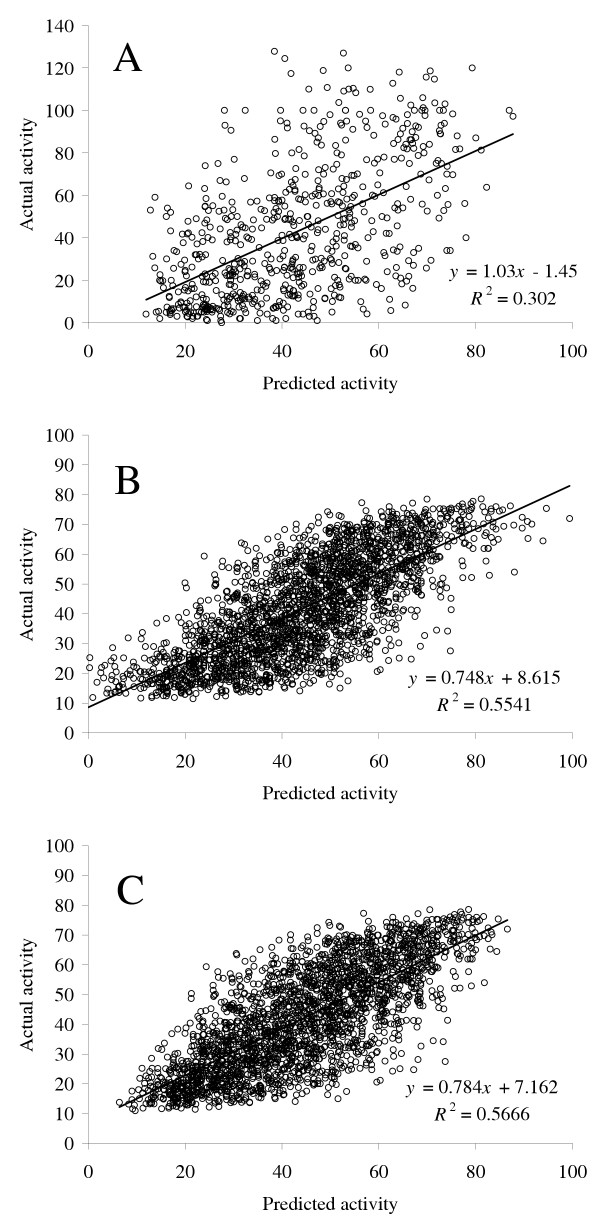
Plot of neural network predictions versus the actual siRNA activity for 653 siRNAs with a broad concentration range (A). Plots of linear regression (B) and neural network predictions versus the actual siRNA activity for the siRNA validation set (C).